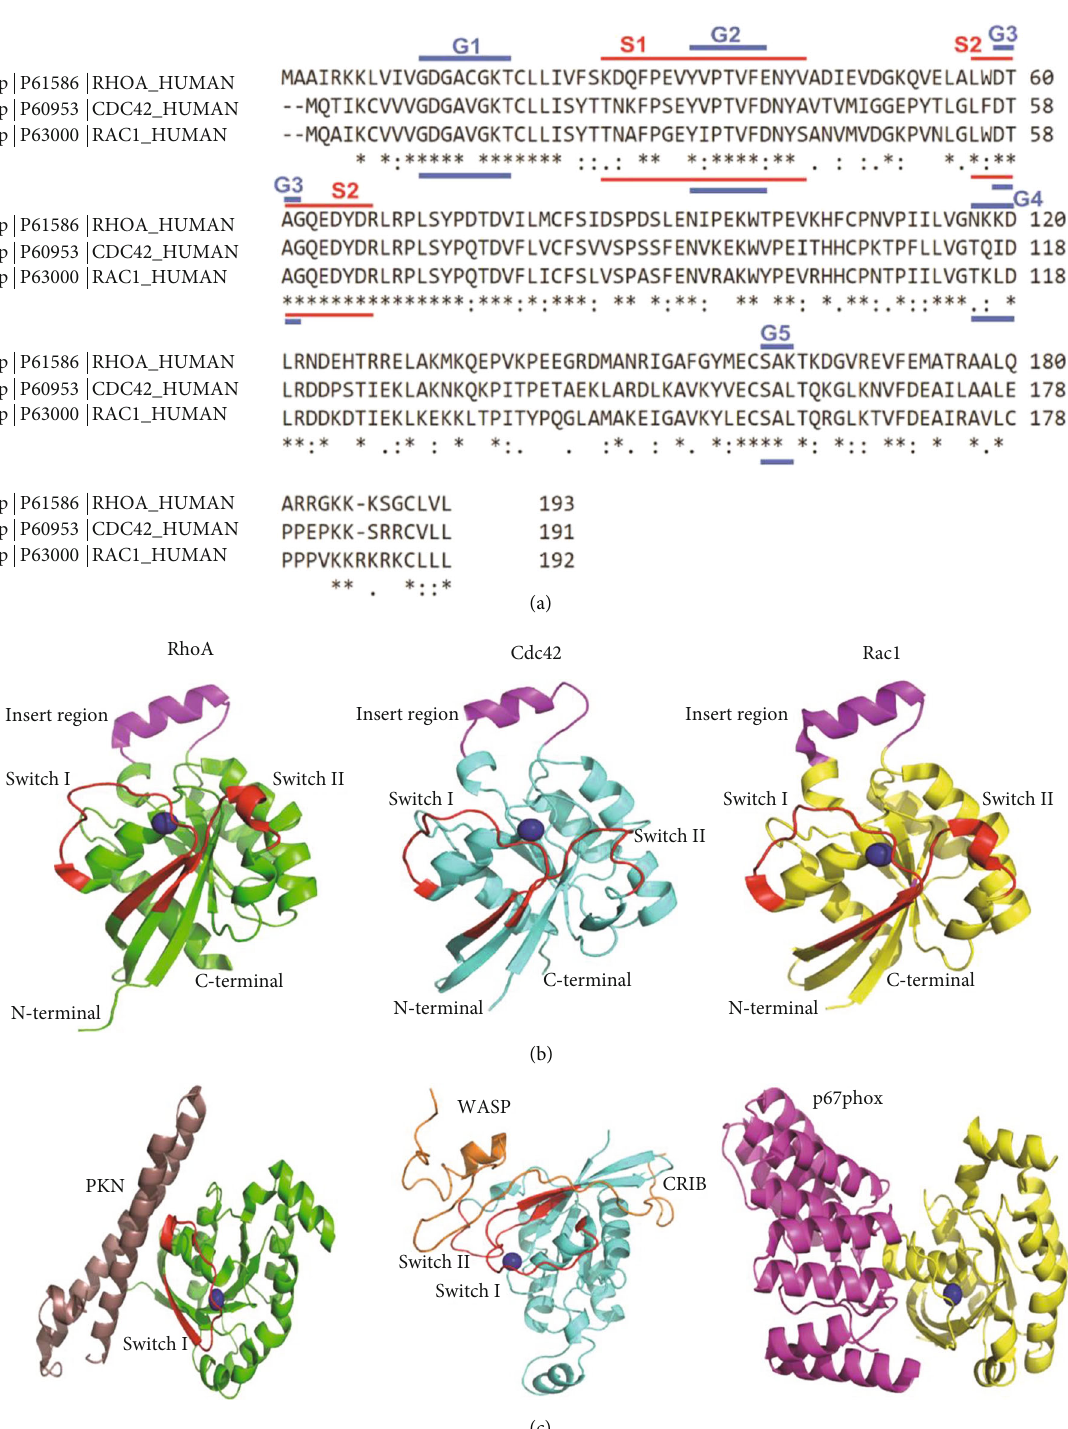
Figure 2: Sequence alignment and structural representation of RhoA, Cdc42, and Rac1. (a) FASTA sequence of RhoA, Cdc42, and Rac1 was retrieved from the Uniprot database, and sequence alignment was performed through the Clustal Omega tool. The length of di ff erent G-boxes (G1, G2, G3, G4, and G5) in the G domain is marked in the blue line, while the length of switch regions is highlighted in the red line. Asterisk represents the entirely conserved column; colon indicates the column where all residues have approximately the same size and hydropathy; full stop indicates the column where the size or hydropathy has been preserved in the course of evolution. (b) Structural representation of RhoA (green color, PDB: 1CXZ), Cdc42 (cyan color, PDB: 1CEE), and Rac1 (yellow color, PDB: 1E96) with their switch I and switch II region highlighted in red and insert region highlighted in magenta color. (c) Structural depiction of RhoA-PKN complex (RhoA in green color and PKN in light brown, PDB: 1CXZ), Cdc42-WASP complex (Cdc42 in cyan color and WASP in orange color, PDB: 1CEE), and Rac-p67phox complex (Rac1 in yellow color and p67phox in bright pink color, PDB: 1E96). The blue color sphere represents the Mg 2+